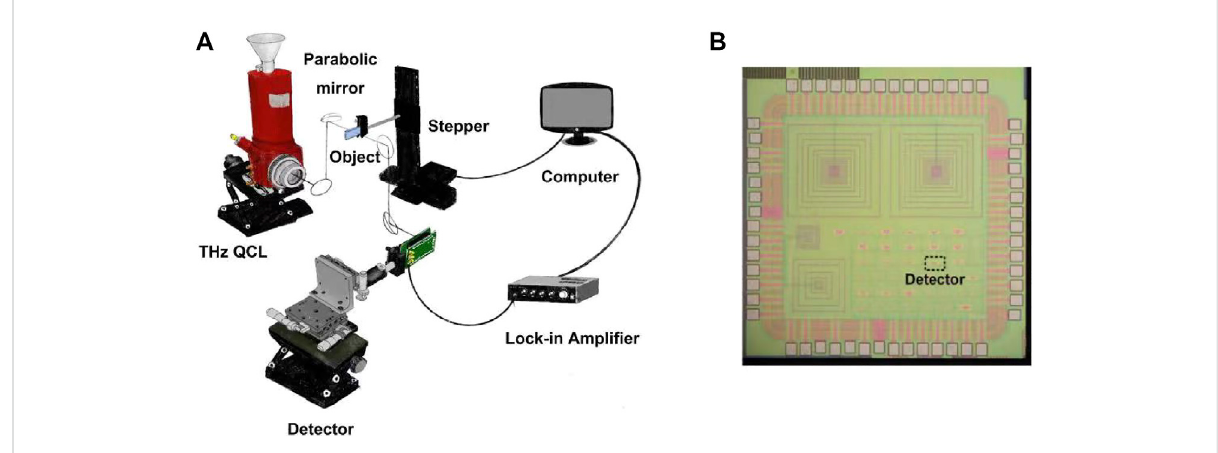
FIGURE 1 (A) Block diagram of the THz imaging system and (B) die photo of the THz